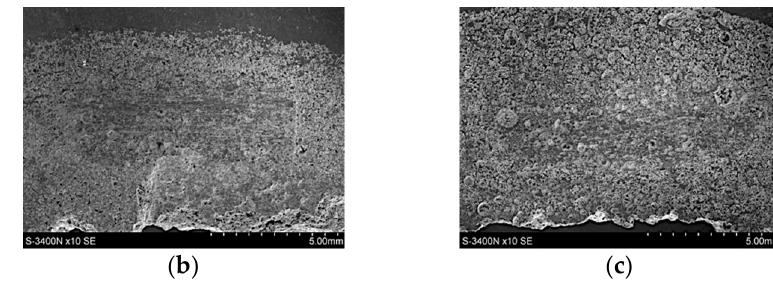
Figure 16. SEM images of the wear tracks on the composite surface: ( a ) AlSi12/GCp; ( b ) AlSi12/SiC p ; and ( c ) AlSi12/SiC p + GC p hybrid composite: ( a , b ) LM; ( c ) SEM.